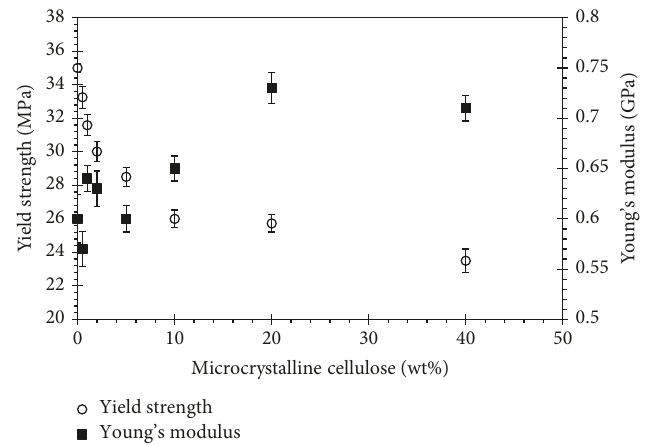
Figure 9: Yield strength and Young’s modulus of neat PP as a function of MCC